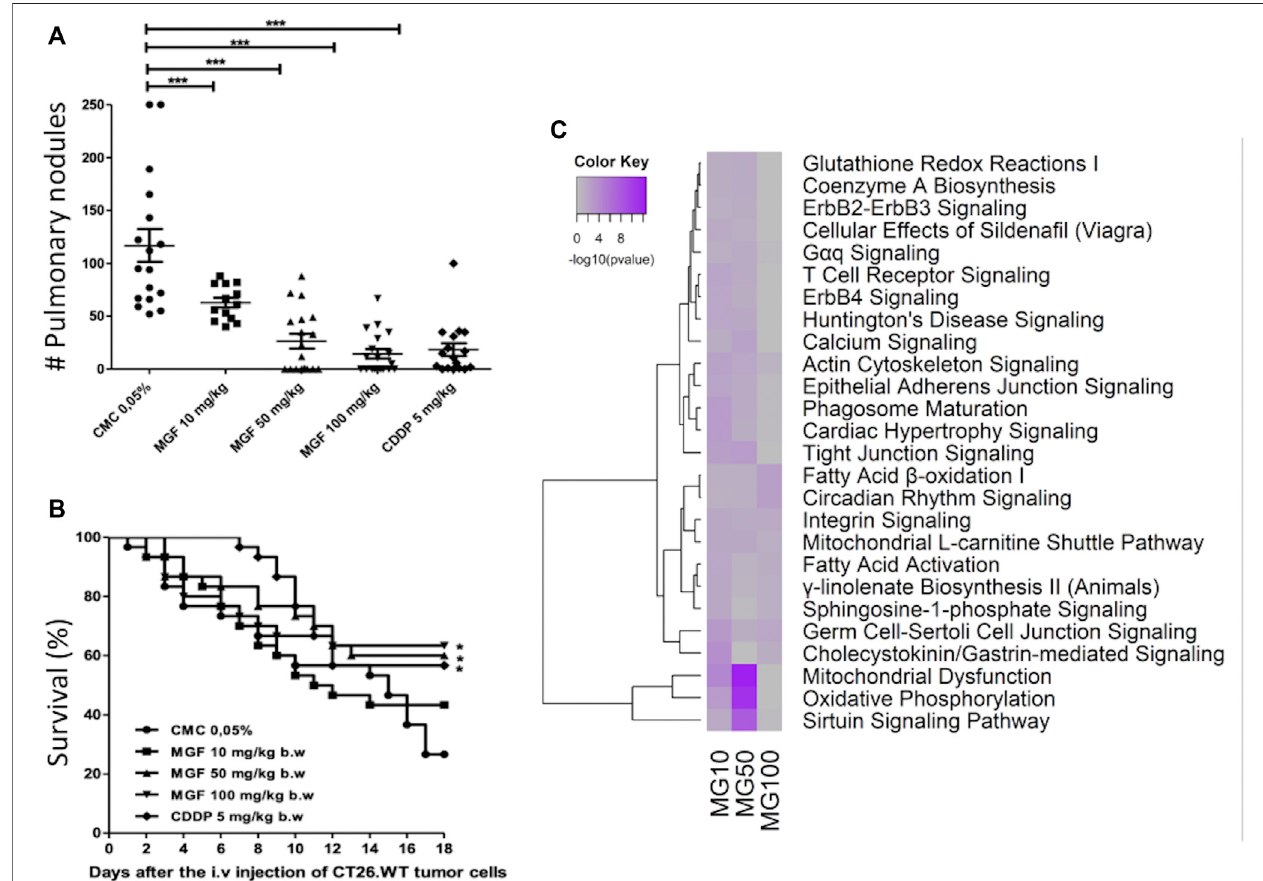
FIGURE 5 | MGF inhibits CT26. WT-induced experimental lung metastasis. BALB/c mice (15/group) were orally treated with 0.05% CMC, MGF 10 mg/ kg b. w., 50 mg/ kg b. w., and 100 mg/ kg b. w. for 17 days, or intraperitoneally with 5 mg/ kg b. w of CDDP (three cycles every days), after injection of CT26. WT cells (1x10 5 cells/100 μ L non-supplemented RPMI culture medium). (A) number of pulmonary surface nodules counted by experimental group. (B) survival curves during 18 days (sacri fi ce) of the experiment to each experimental group. Values are shown as mean ± standard error of the mean (SEM) of three independent experiments. MGF signi fi cantly inhibited (*** p < 0.001) tumor lung metastasis as shown in panel A and signi fi cantly increased survival of mice as shown in panel B, as compared to vehicle control treatment response. (C) heatmap representations of most signi fi cantly enriched pathways associated with gene expression changes in response to MGF